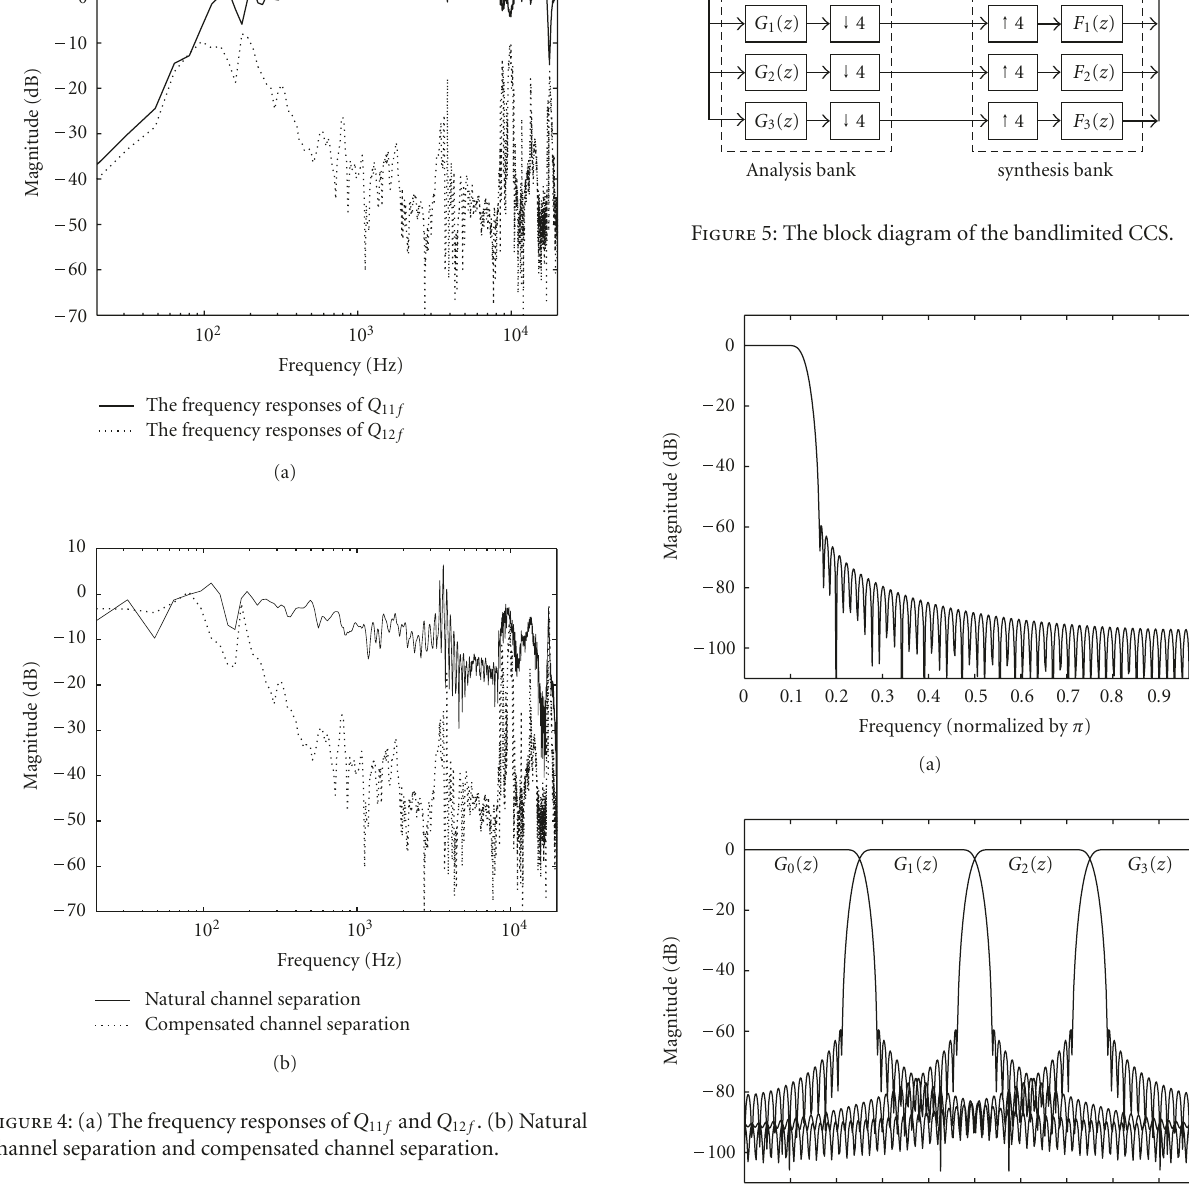
well trained by playing the stimuli of all angles prior to the